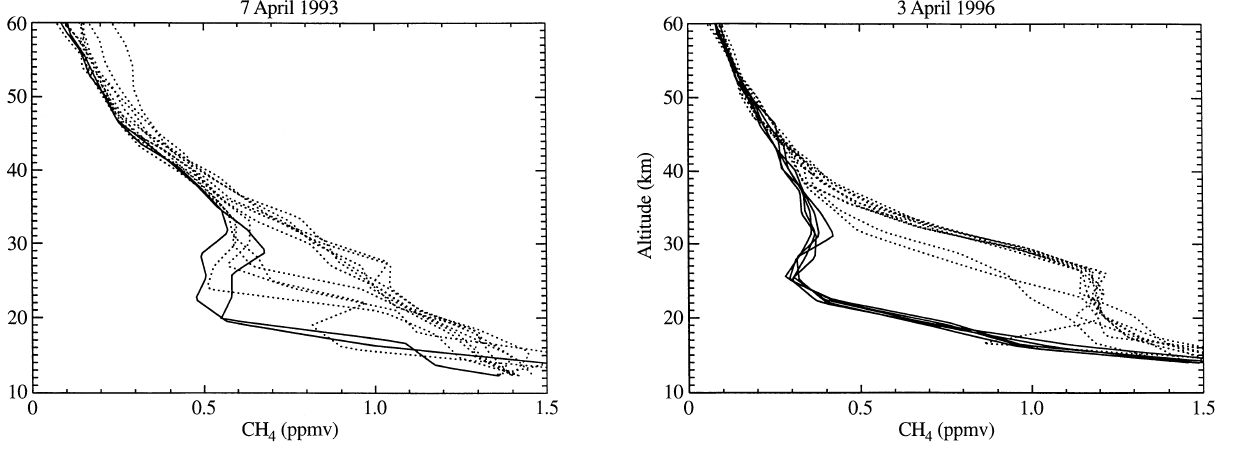
Fig. 18. As Fig. 17, but for HALOE measurements of CH 4 vertical profiles at 69 (cid:14) N on April 3, 1996